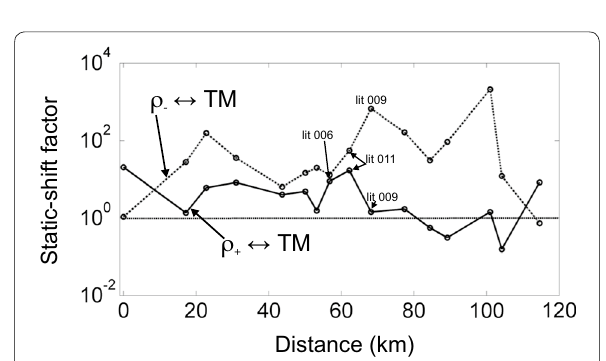
Fig. 11 Static‑shift factors for the different sites for the cases of ρ TM and ρ TM. Notice that factors are about two orders − ↔ + ↔ of magnitude larger in the former case than in the latter. The three signaled sites are the same depicted in detail in this